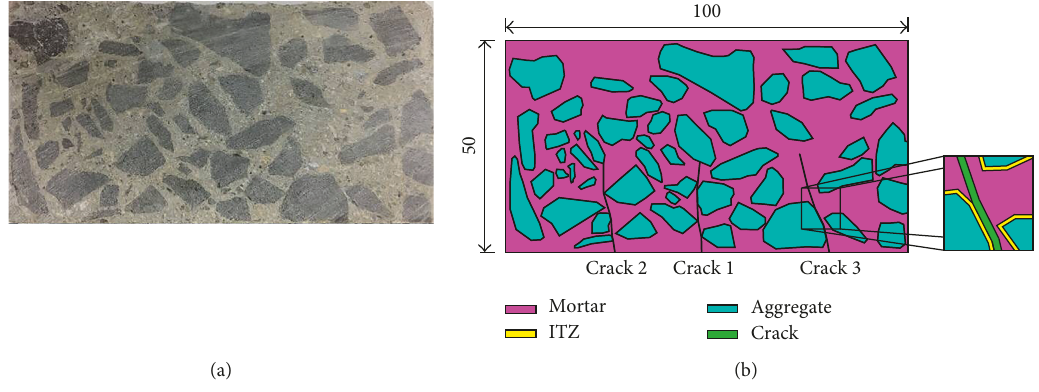
Figure 6: Concrete numerical model. (a) Concrete cross section. (b) Four-phase numerical